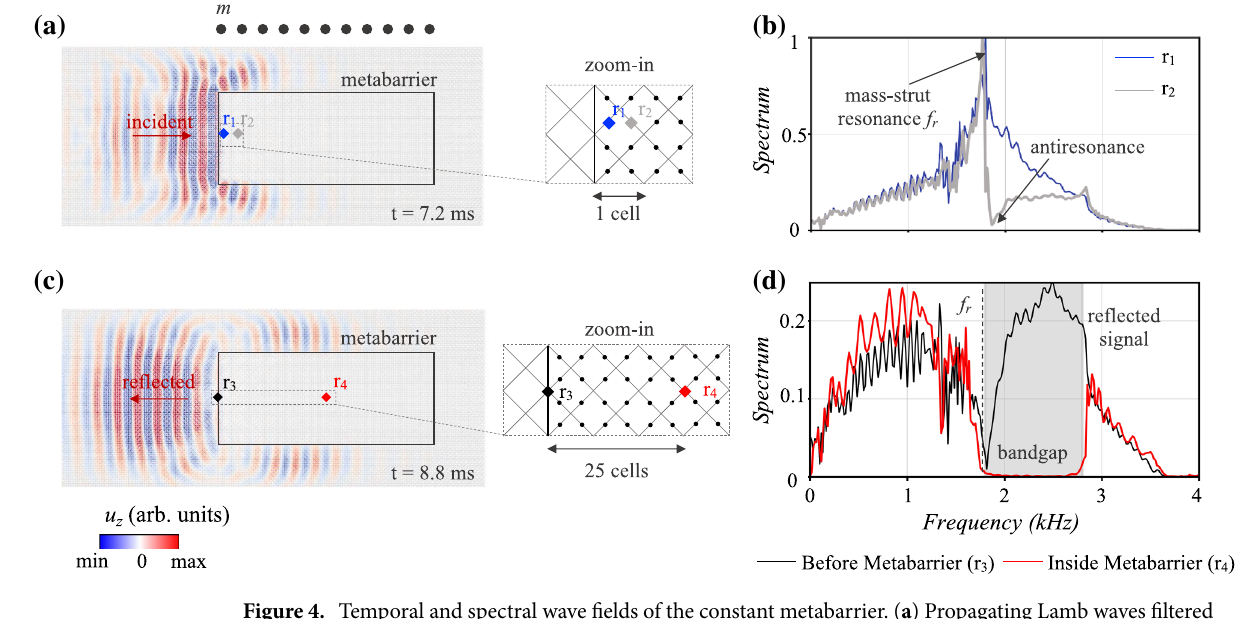
Figure 4. Temporal and spectral wave fields of the constant metabarrier. ( a ) Propagating Lamb waves filtered within the bandgap (1.8 - 2.8 kHz). The output signal is recorded in two points, r 1 and r 2 , arranged on the midpoint of the struts atop the embedded masses in order to validate the hypothesis of hybridization bandgap. Their spectrum is reported in ( b ). ( c ) Filtered displacement field at a later time instant. The back propagating, reflected wavefront is emphasized by the red arrow. Two receivers, located respectively before and within the barrier, are shown in the zoom. Their spectra are compared in ( d ), after normalization with the peak value of ( b